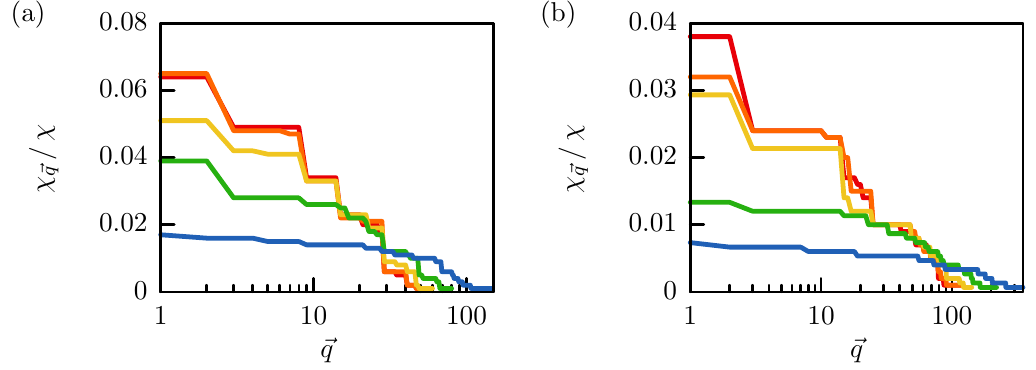
Figure 14: Local MPS dimension (green boxes) over system width L of static charges. Compared to unconstrained spin 1 / 2 with ˜ d = 4 L actual dimensions grow with d ≈ 0.53 × 2.84 L (green dashed line).